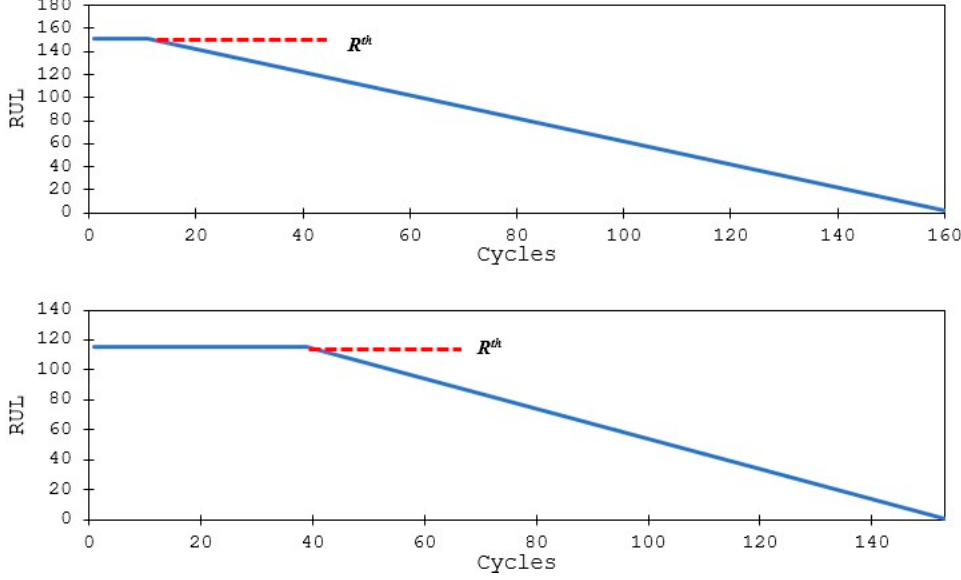
Figure 9. Example of RUL curve of one testing engine: FD002 ( top ) and FD004 ( bottom ).